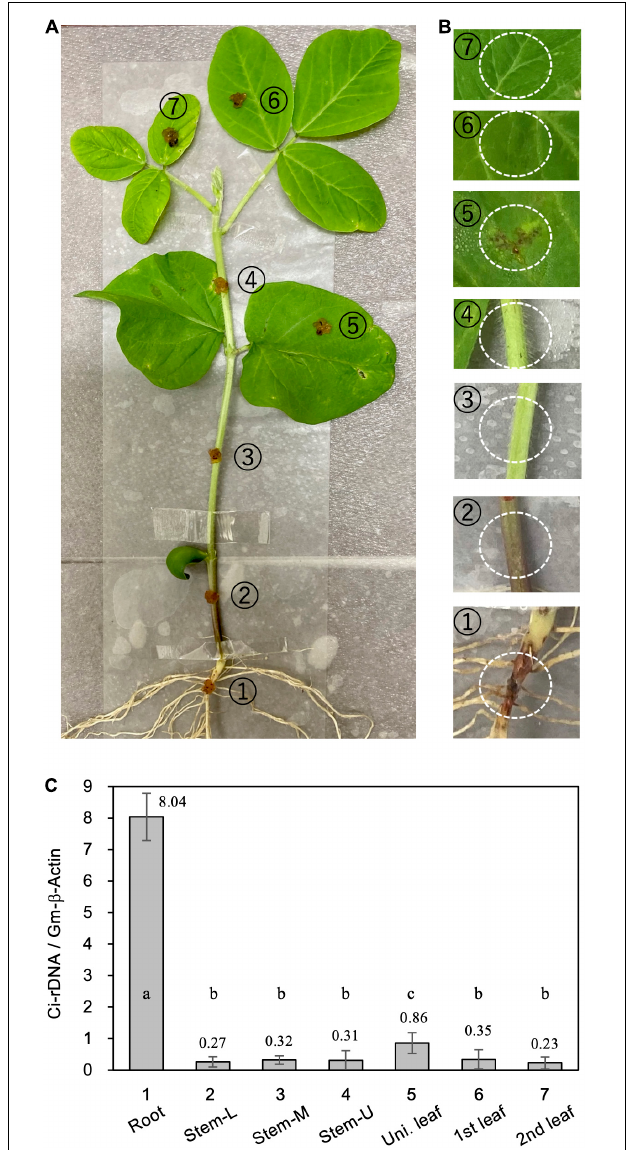
FIGURE 2 | Relative fungal growth in different parts of soybean plants. (A) Calonectria ilicicola was inoculated to a 5-mm-diameter spot on (1) radical root, (2–4) lower (Stem-L), middle (Stem-M), and upper (Stem-U) portions of stem, and (5–7) unifoliate (Uni. leaf), first and second trifoliate leaves (1st and 2nd leaf) of 4-week-old soybean plants. (B) Images of inoculated spots (white dotted circles) 6 days after inoculation. (C) Relative fungal growth (Ci-rDNA/Gm-b-Act1) in the inoculated parts of soybean plants. Values are means ± SD, n = 5 plants. Different letters indicate significant differences (Turkey’s multiple comparison test, p <